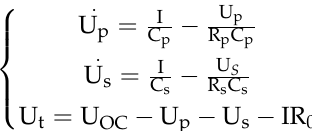
Figure 10. Equivalent circuit model of second-order RC network.